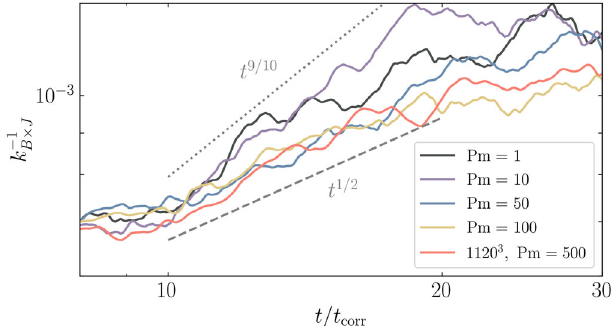
FIG. 7. Time evolution of the field-reversal scale k − 1 B the nonlinear stage at resolution 2240 3 for different Pm (runs d1, d2, d3, d4) and at resolution 1120 3 with Pm ¼ 500 (run c7; here, k B × J is multiplied by an arbitrary factor of 1.4 to bring it nearer visually to the other curves).